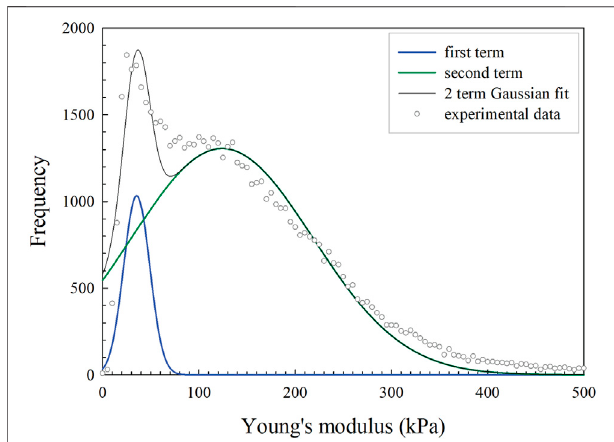
FIGURE1| Anexampleofatypicalfrequencysetfromhistogramdataof a single image of an untreated collagen prepared from 2 mg/ml solution (grey open circles). There are clearly two peaks and their approximate locations were used as initial guesses for b values for a two term Gaussian model (blackline). The individualcontributions from thesofter peak (blueline) and the stifferpeak (greenline)canbeseenunderneaththetwotermGaussianmodel.